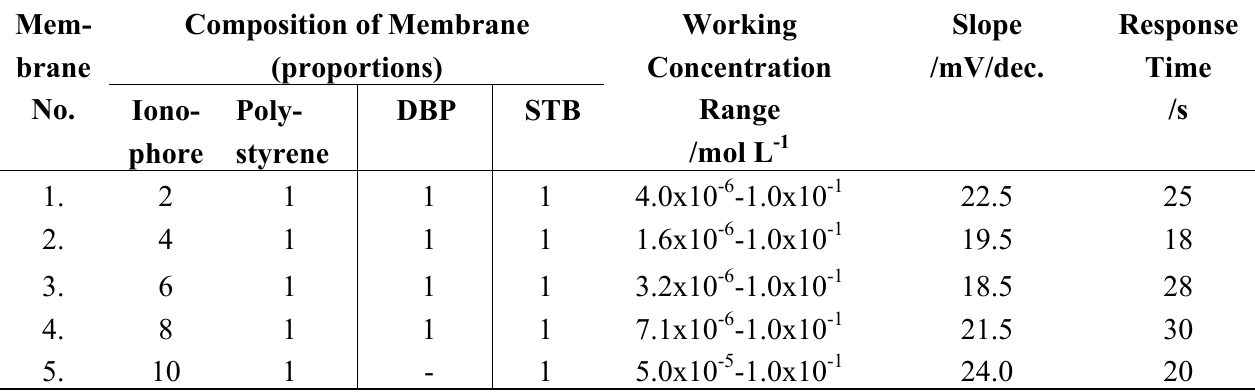
Table 2. Composition of polystyrene based membranes of [Me performance as Cr 3+ selective